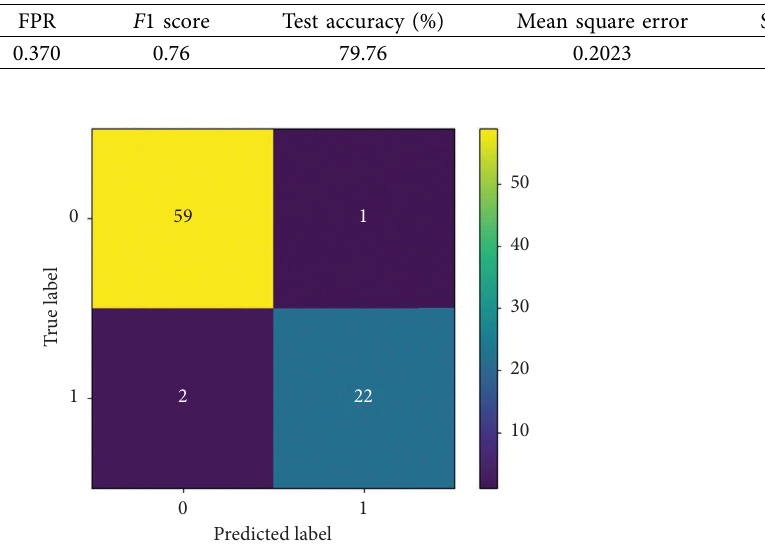
Figure 11: LR classifcation confusion matrix.